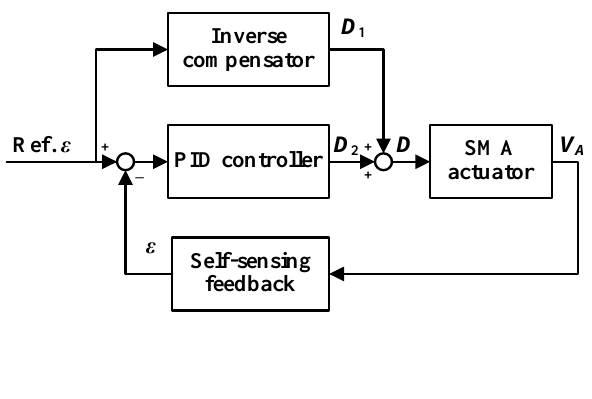
Figure 12. Flow diagram of the SMA actuator length